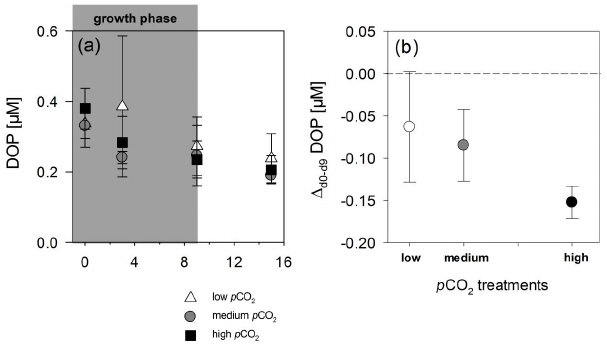
Fig. 7. DOP concentration over time at low (triangle), medium (cir- cle) and high (squares) p CO 2 (a) and changes from day 0 to day 9 (b) . Differences between treatments are not significant. Symbols display the mean of three replicates with standard